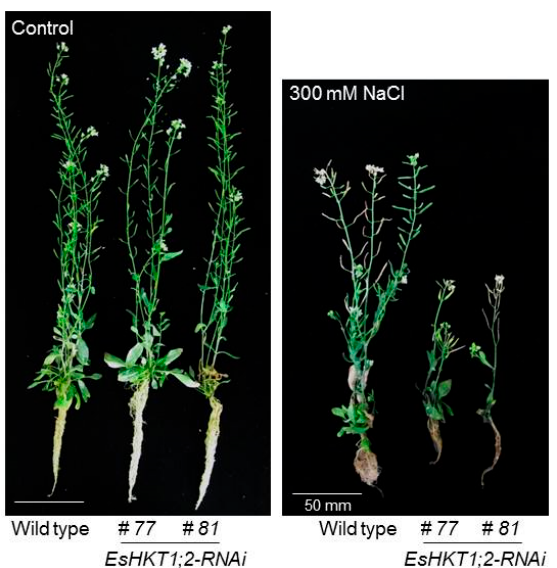
Figure 3. EsHKT-RNAi plants are sensitive to low K + -limiting conditions. Wild type and knock-down lines of EsHKT1;2 ( EsHKT1;2-RNAi ) were grown on MS-medium for 10-days and then transferred to K + -deficient media with 0, 1 and 10 mM KCl (see Ali et al. 2012 for the detailed methodology) and allowed to grow for further 10-days. EsHKT1;2-RNAi lines were more sensitive to K + -limiting conditions as compared with the wild type Control. A gradual increase of K + concentration greatly promotes the growth of wild type plants, whereas EsHKT1;2-RNAi lines were still sensitive. This result demonstrates the crucial role of EsHKT1;2 for K + -uptake.